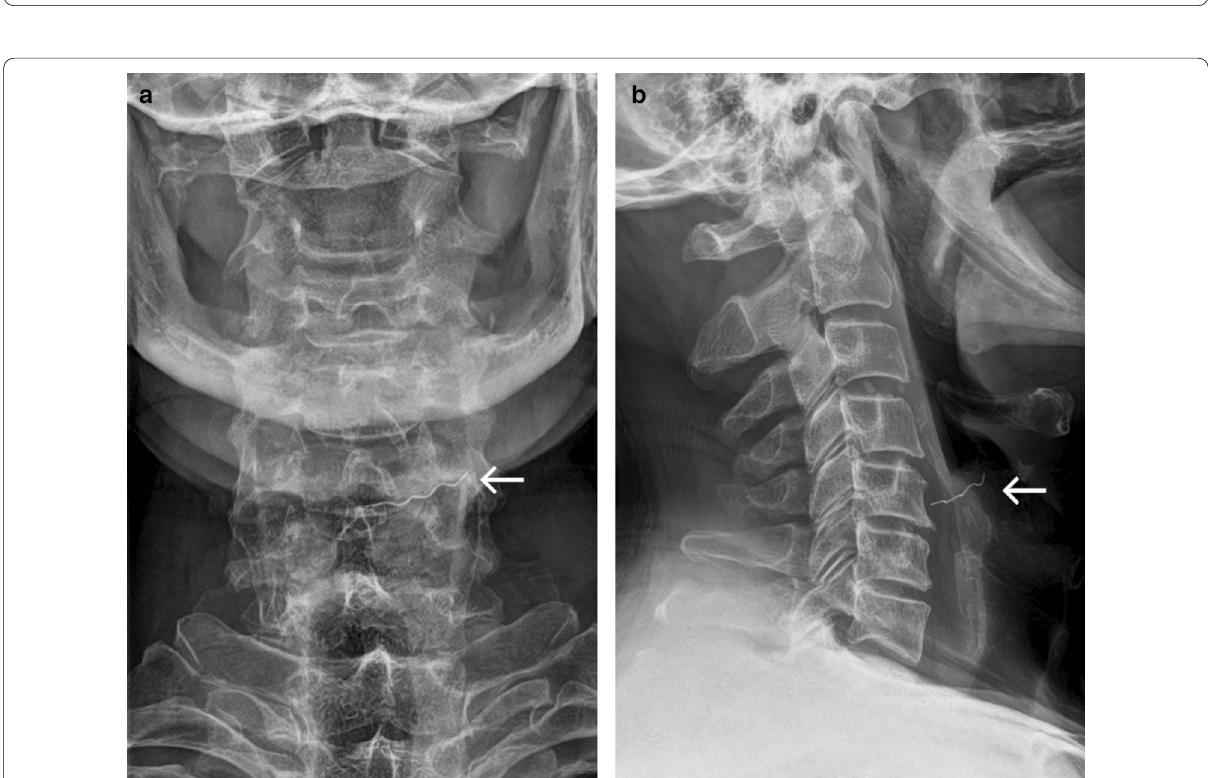
Fig. 9 Metal wire. Anteroposterior ( a ) and lateral ( b ) radiographs showing a thin radiopaque structure (arrow) in projection over the hypopharynx anterior to the 5th cervical